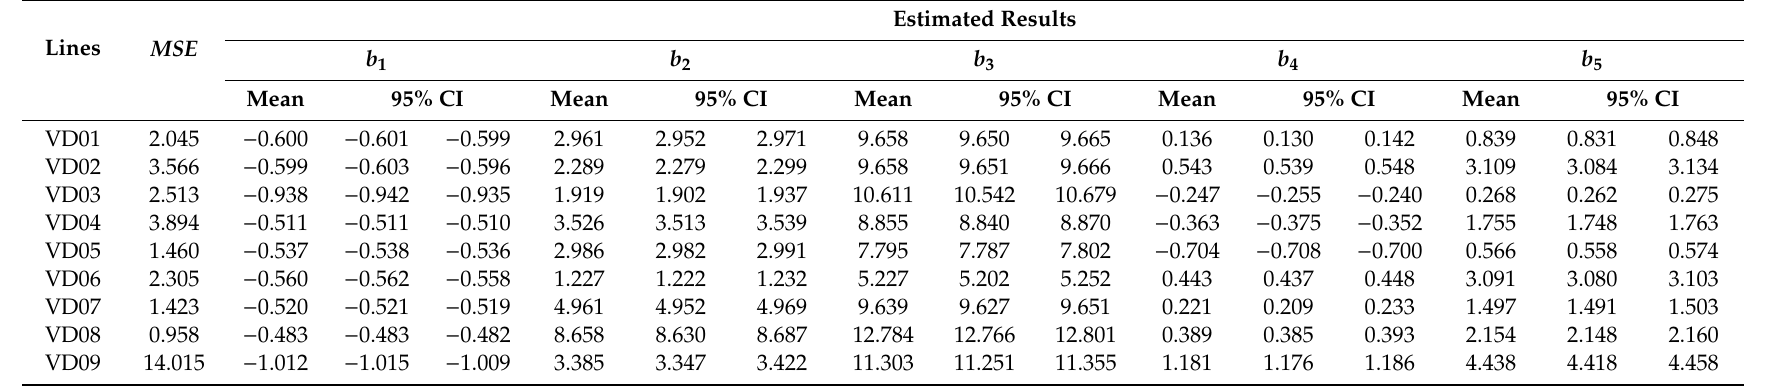
Table 1. Estimated results of the GHS model